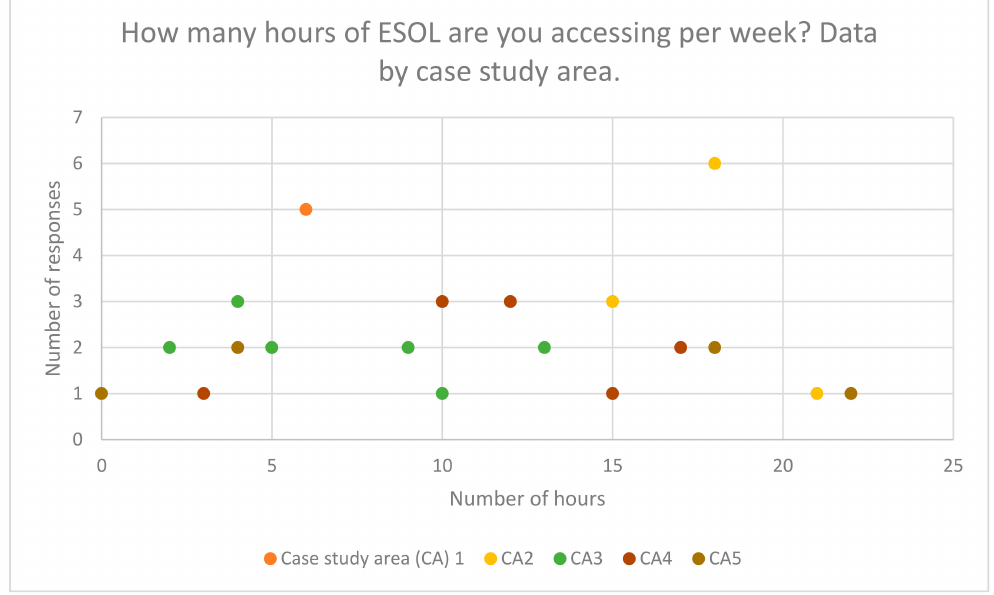
Figure 2. Scatterplot indicating responses to the question ‘How many hours of ESOL [English for speakers of other languages] instruction are you accessing per week?’ Data shown by case study